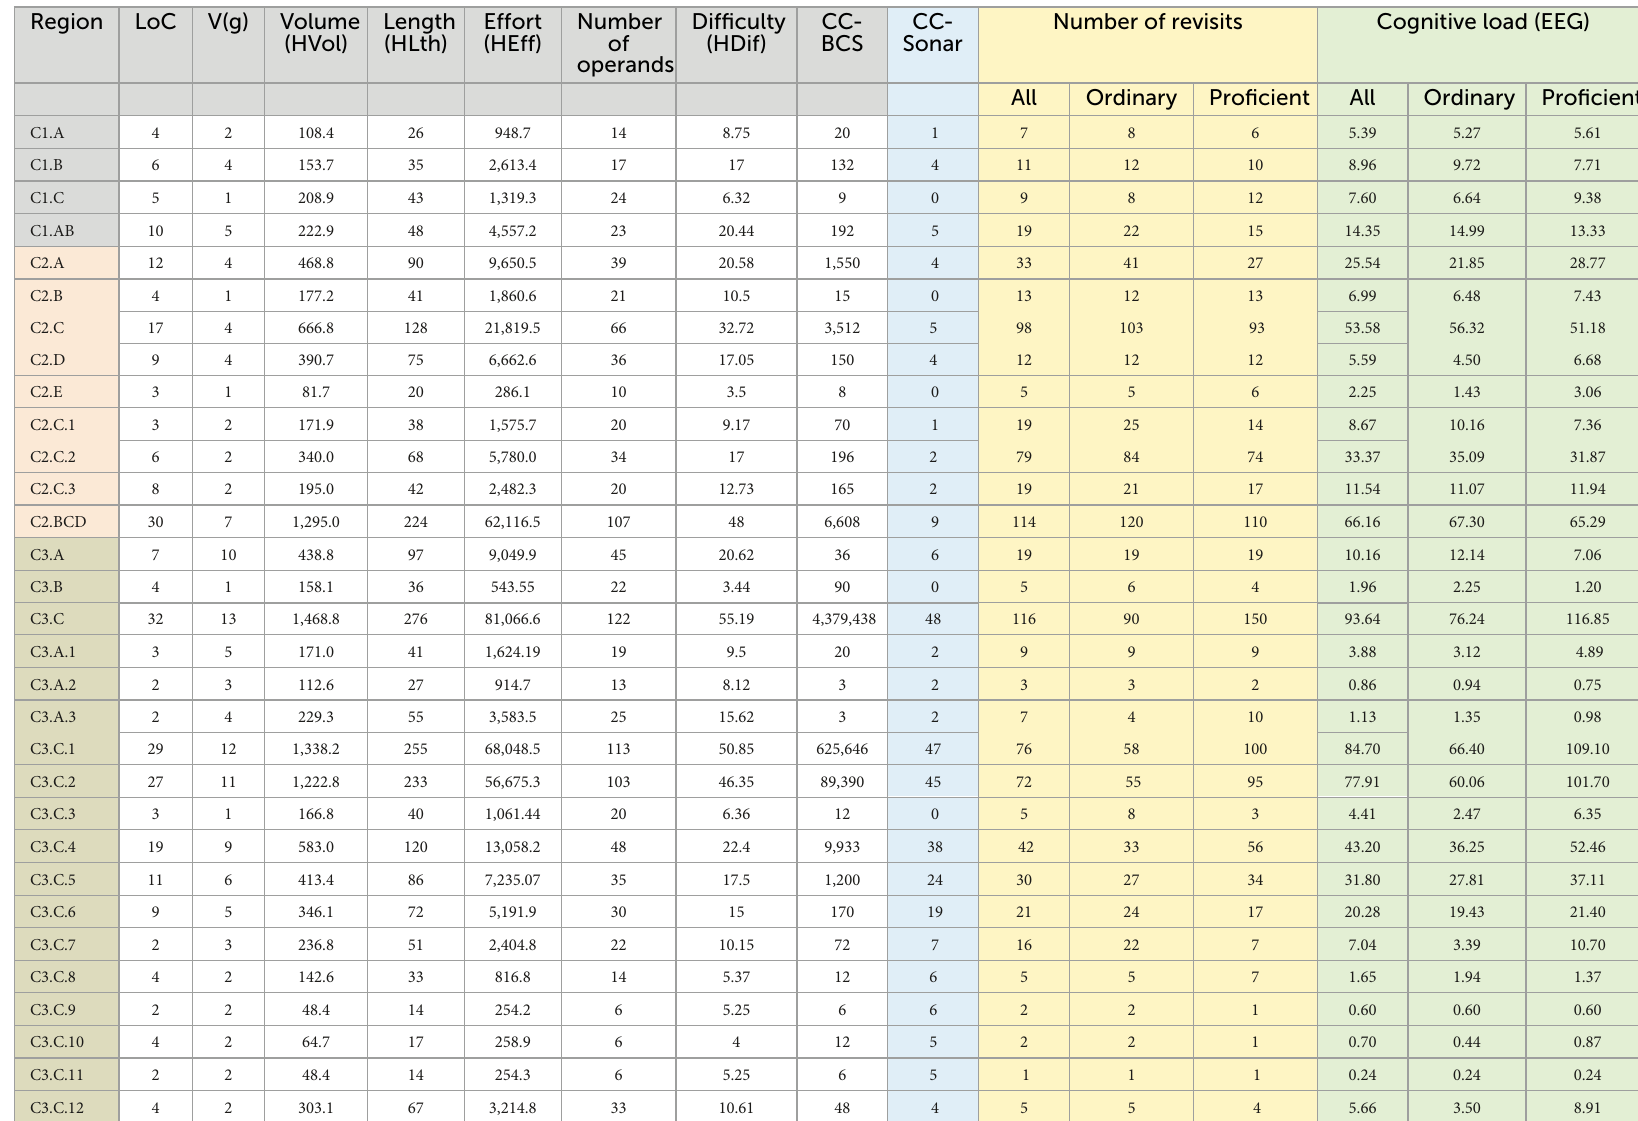
TABLE 8 Detailed results for code